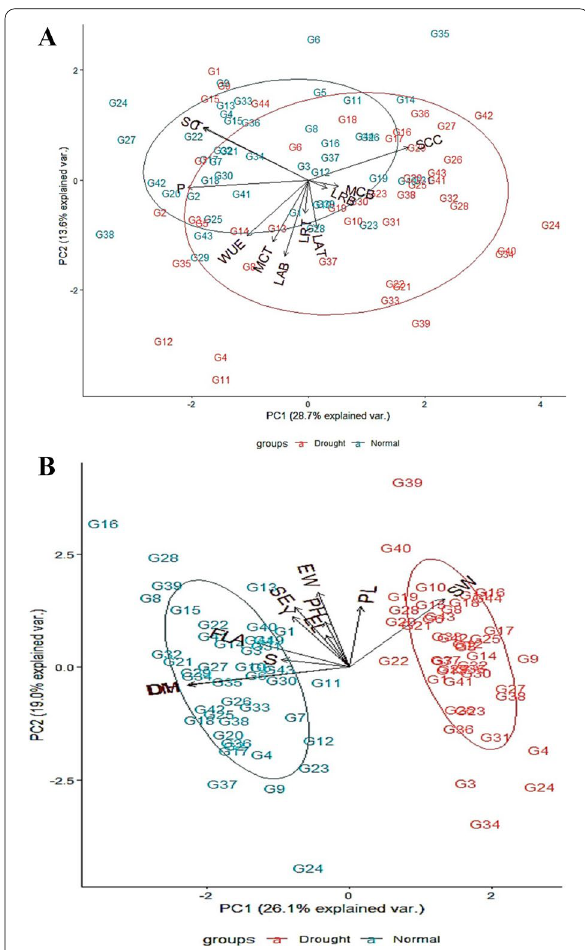
Fig. 5 Biplot analysis of A leaf traits i.e. leaf rolling (LRT and LRB), leaf angle (LAT and LAB) at tillering (T) and booting (B), moisture capturing (MC), physiological parameters i.e. stomatal conductance (SC), sub stomatal conductance (SCC), photosynthesis (P), transpiration (T) and water use efficiency (WUE), and B yield parameters i.e. flag area (FLA), peduncle length (PL), ear length (EL), plant height (PH), days to heading (DH), days to maturity (DM), ear weight/spike (EW), seed weight/spike (SW), spikelets/spike (SS), no. of seed/spike (SE) and yield/plot (Y) of 44 wheat genotypes. Arrows show the magnitude of the traits for their respective environment. The ellipse shows the groups of normal and drought added by the default confidence interval of